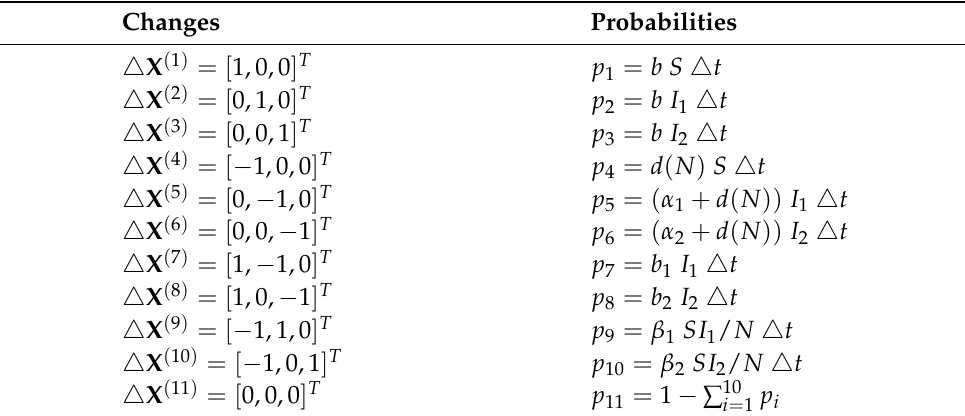
Table 1. Possible change in X = ( S , I 1 , I 2 ) T and their